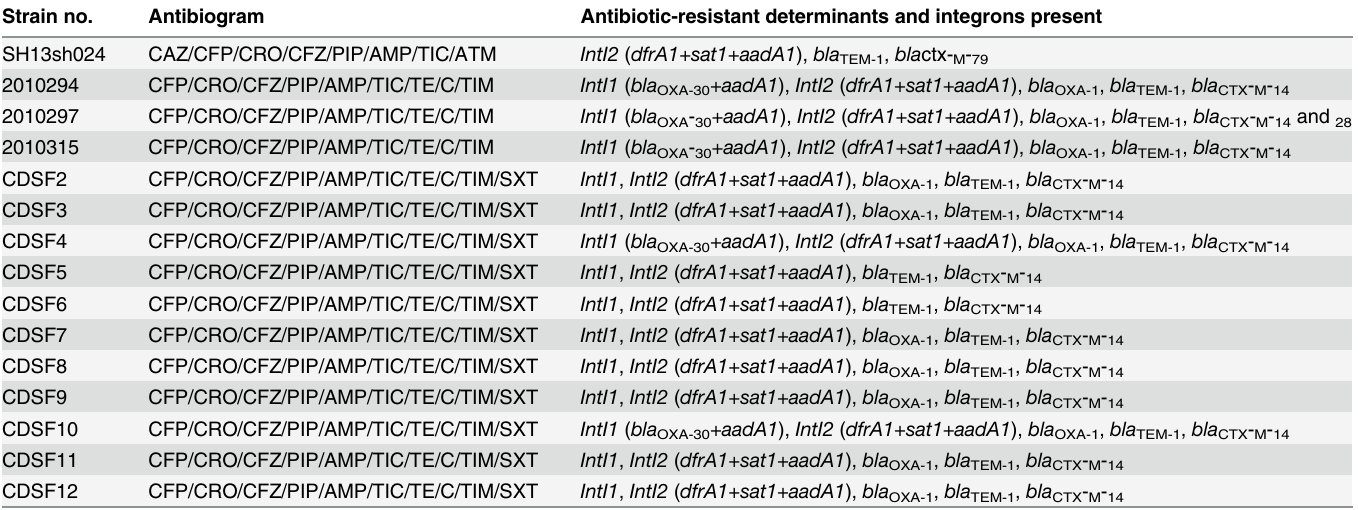
Table 6. Antibiogram and molecular analysis of the antibiotic-resistance determinants and integrons of 15 cephalosporin resistant isolates. Strain